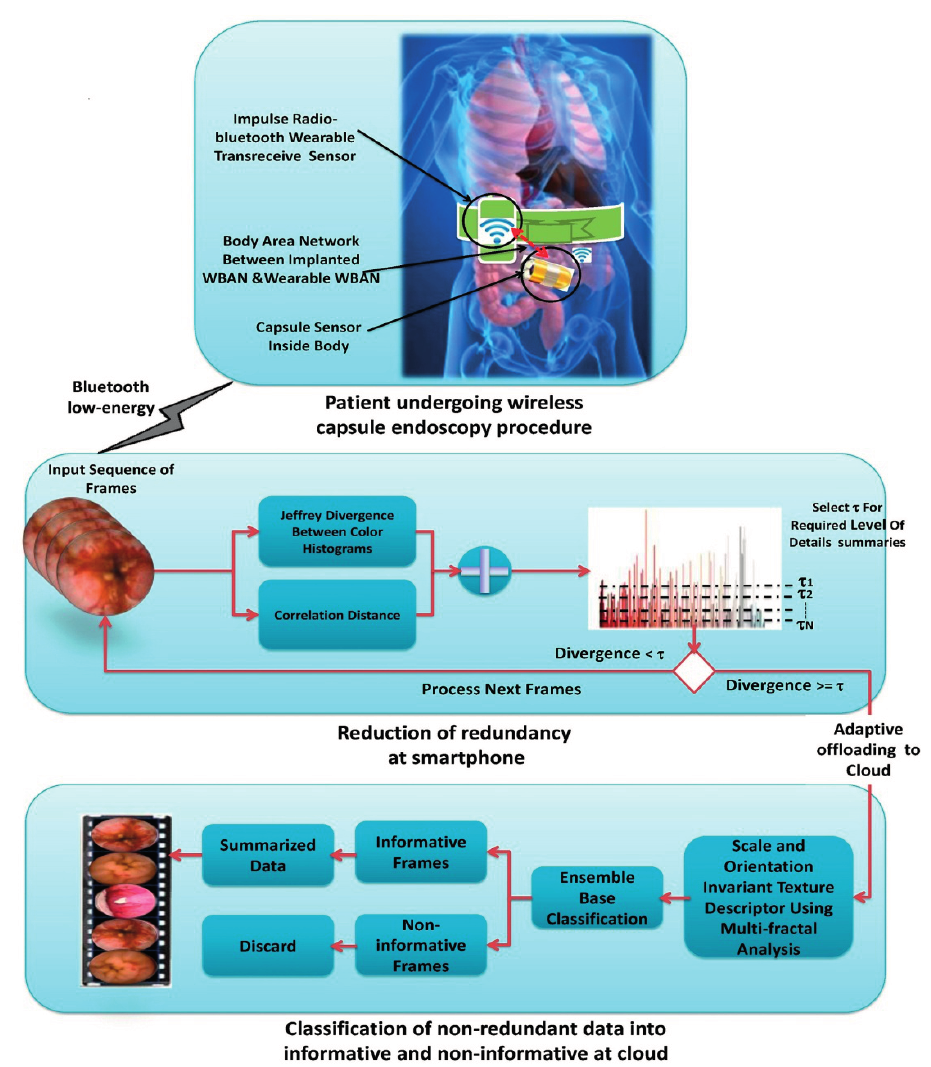
Figure 4. Illustration of the WCE data summarization